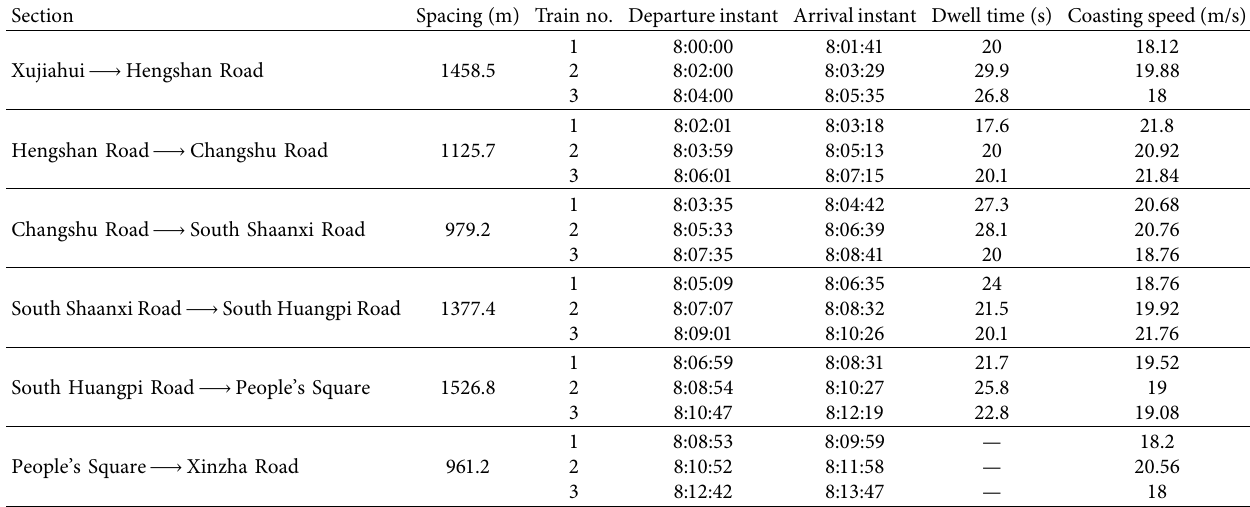
Table 7: The rescheduled timetable with the MGA-GRU method of the three-train system.